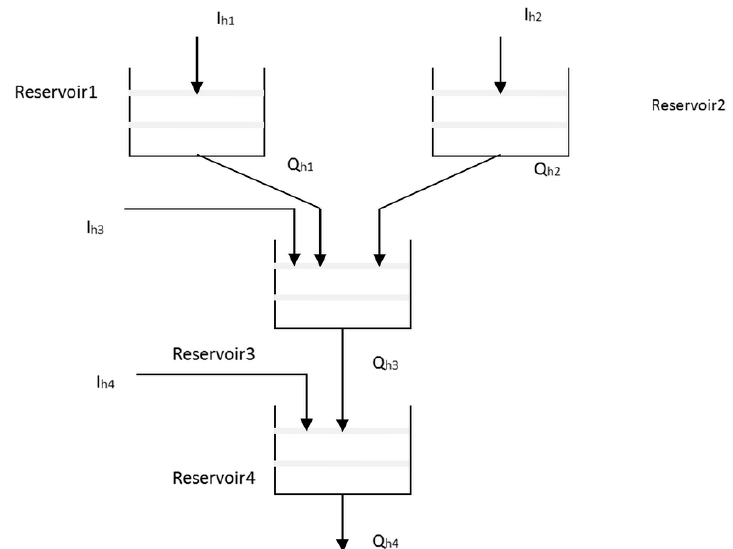
Figure 2. Hydro subsystem used in the all test systems. Table 1. Hourly plant discharges, power outputs and total thermal generation (test system 1, case 1).